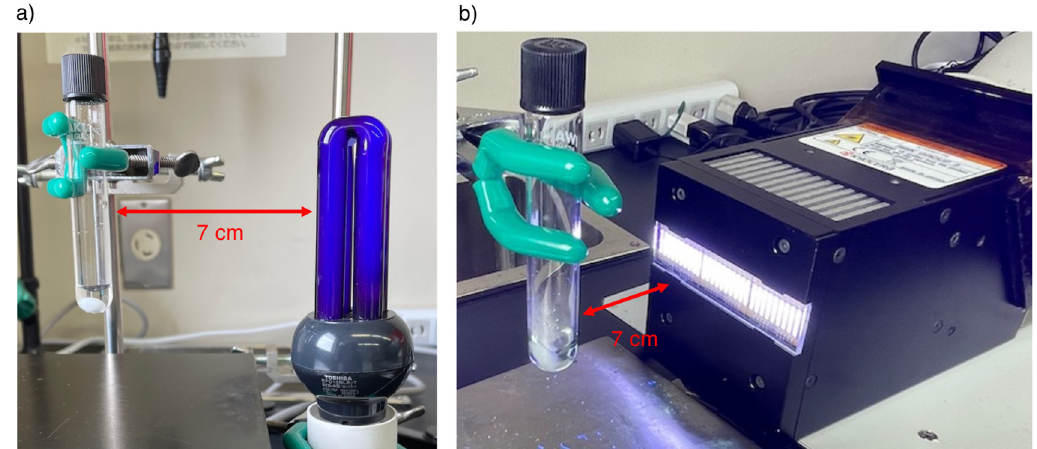
Figure 2. Photo-irradiation setup: ( a ) test tube reactor irradiated by a low-power blacklight (352 nm); ( b ) test tube reactor irradiated by a high-power UV-LED-S (365 nm).